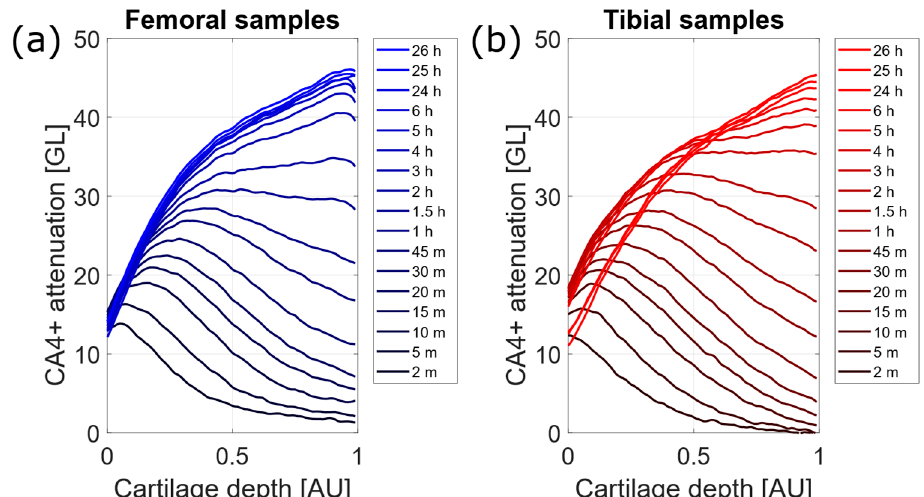
Figure 3. Mean attenuation profiles reported as a function of cartilage depth for femoral ( a ) and